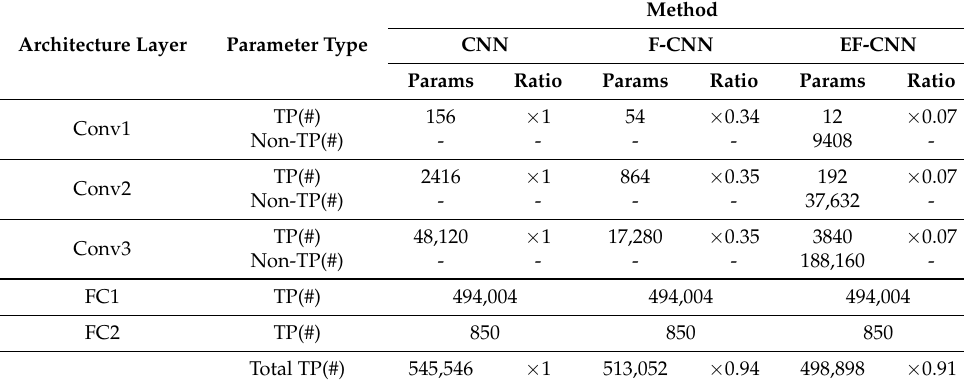
Table 8. The number of parameters of LeNet-5 on the Fashion-MNIST dataset for each CNN, Fourier CNN and efficient FCNN. TP : trainable parameters. Non-TP : non-trainable parameters.